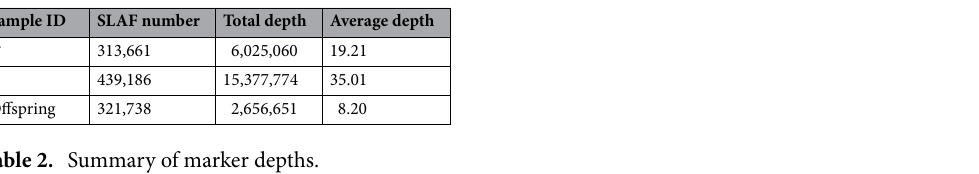
Table 2. Summary of marker